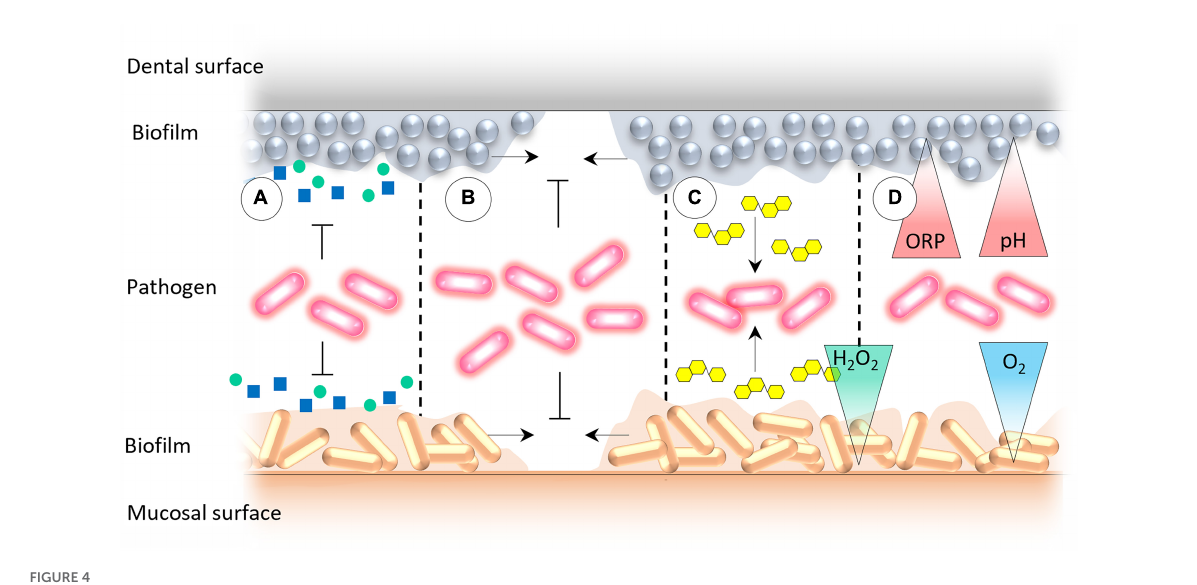
FIGURE4 The mechanisms that underpin the oral colonization resistance: (A) Competition for essential nutrients and co-factors for microbial growth, (B) competition for binding sites for microbial attachment on mucosal and dental surfaces, (C) production of antagonistic compounds by the resident oral microbiota, and (D) creation of adverse environmental conditions that prevent the growth of exogenous